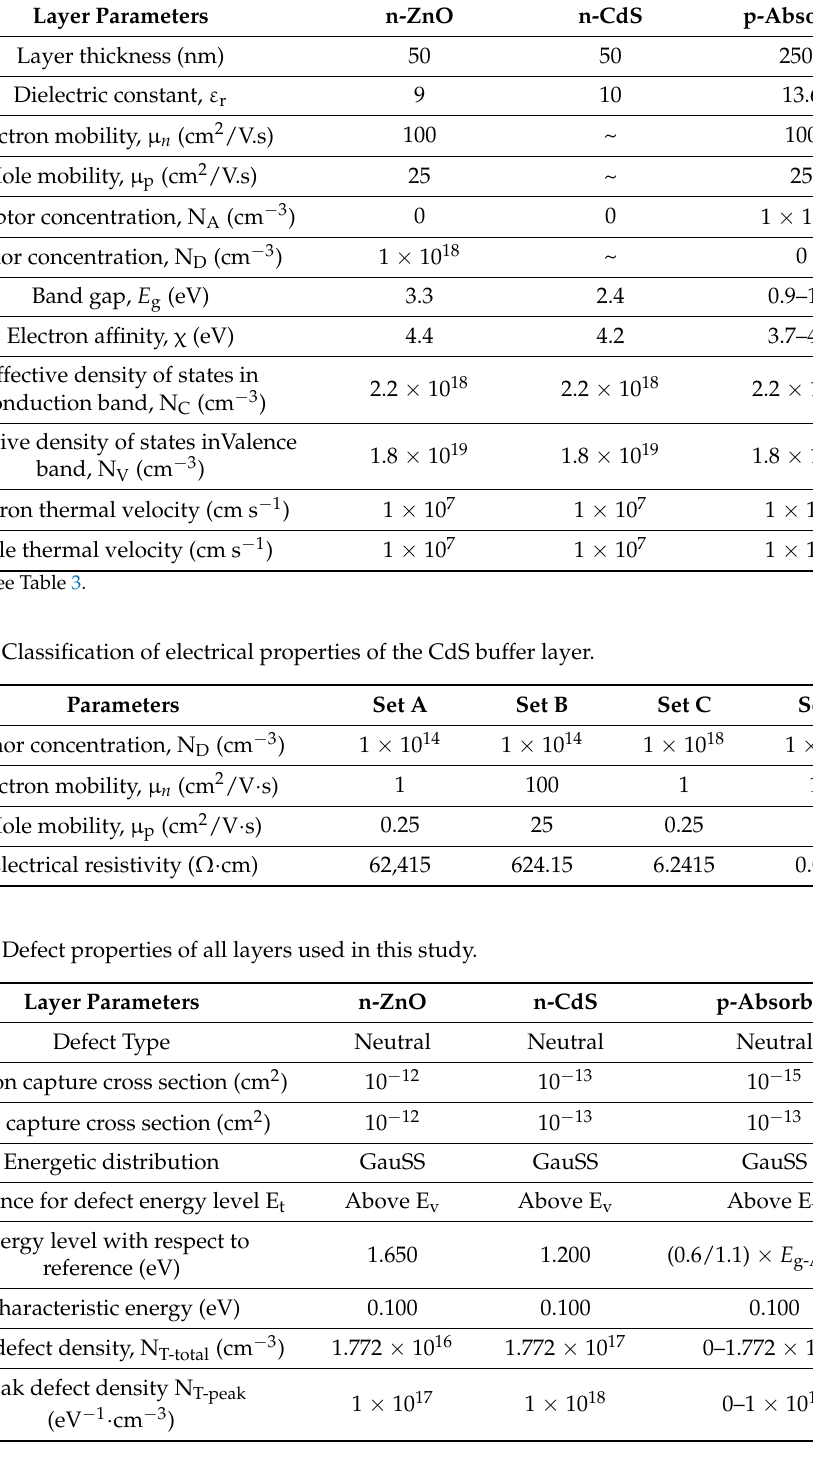
Table 2. List of physical and electronic properties for layer parameters.